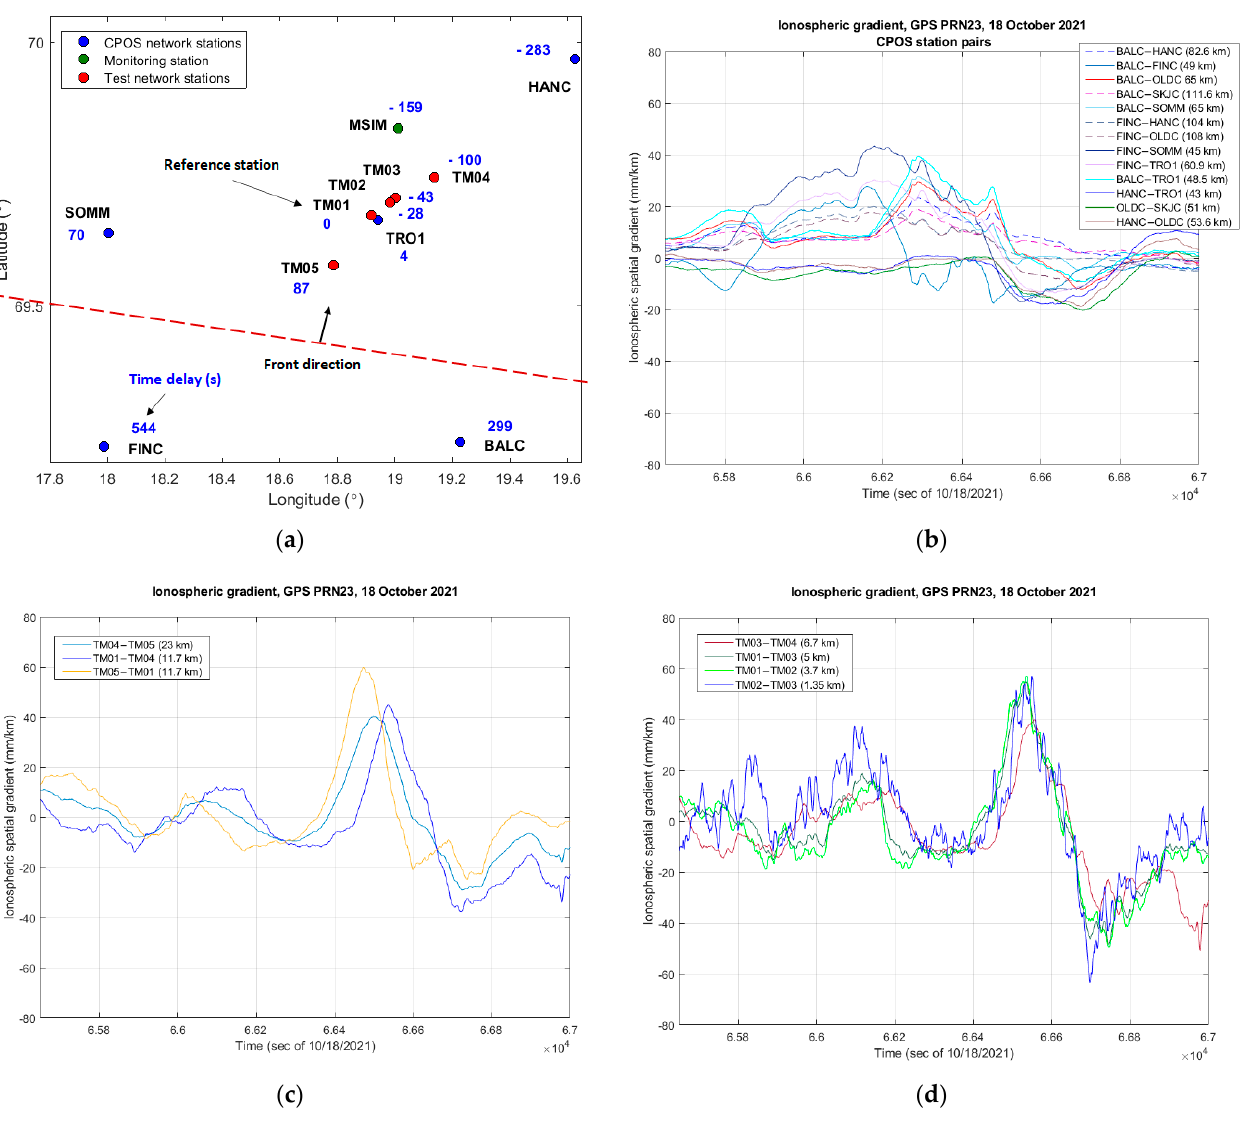
Figure 6. ( a ) Observed time delay relative to the reference station (here TM01); ( b ) Ionospheric spatial gradient observed by the CPOS station pairs in the cluster, baselines ranging from 43–111 km; ( c ) Ionosphere spatial gradient observed by the test receivers located on baselines ranging from 11.7– 23 km; ( d ) Ionospheric spatial gradient observed by the test receivers located on the shortest base- lines ranging from 1.35–6.7 km.